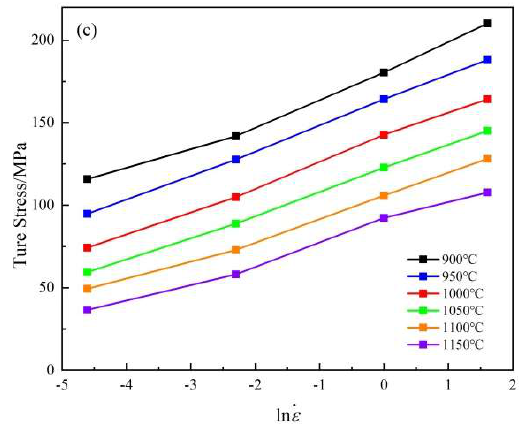
Figure 3. Peak value of flow stress curve ( a ) T = 1050 °C, 𝜀̇ = 0.01 s −1 ( b ) T = 900 °C, 𝜀̇ = 0.1 s −1 , ( c ) Peak stress under various parameters The above method was used to further study the relationship between different temperatures and strain rates and peak stress. The results are shown in Figure 3c. The peak stress increases with the increase of strain rate and decreases with the increase of temperature.